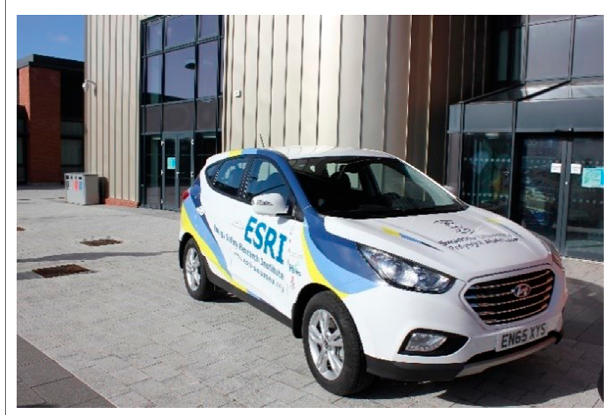
FIGURE 3 | The ESRI Hyundai Ix35, a hydrogen fuel cell-powered car that transports The Hydrogen Bike team and equipment to events.